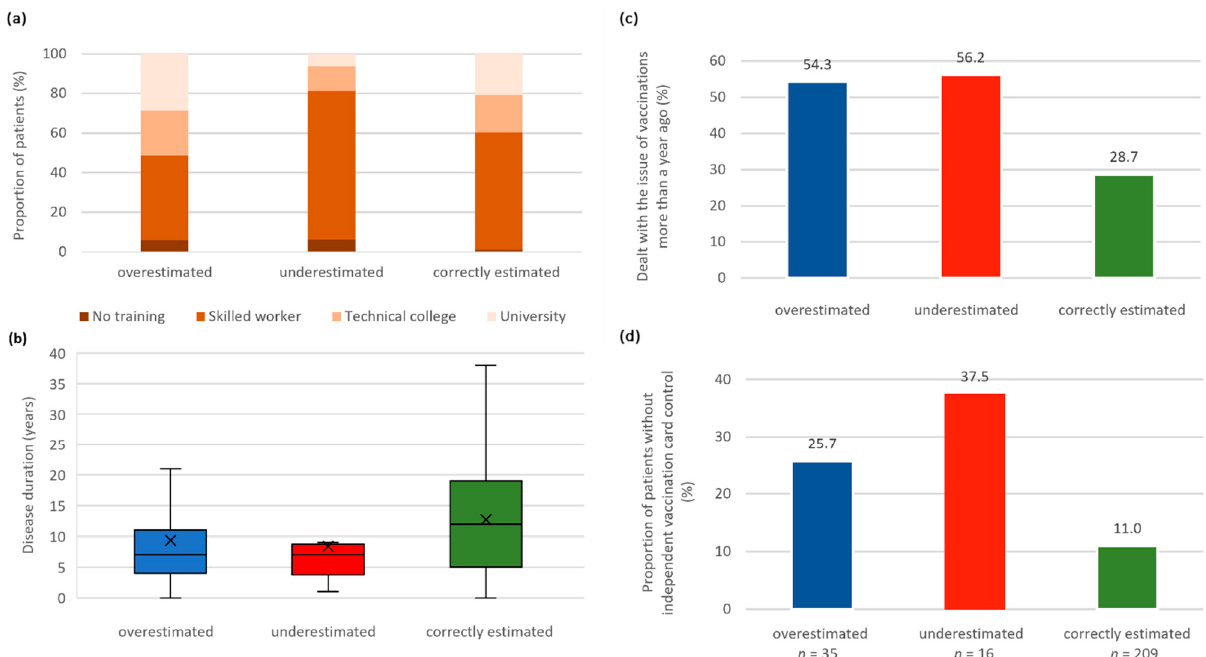
Figure 3. Assessment of diphtheria vaccination status by MS patients in relation to education, disease duration, vaccination interest, and vaccination control. Patients who underestimated their vaccination status were significantly more likely to be educated as skilled workers and less likely to have a university degree ( p = 0.004 Chi ) ( a ). Patients who correctly estimated their vaccination status had a significantly longer disease duration ( p = 0.004 Chi ) ( b ), were less likely to not address the issue of vaccinations for more than a year ( p = 0.001 Chi ) ( c ) and were less likely to not have a contact person for vaccination card control ( p = 0.005 Chi ) ( d ). Chi —chi-squared test; n —number of patients; p — p -value.